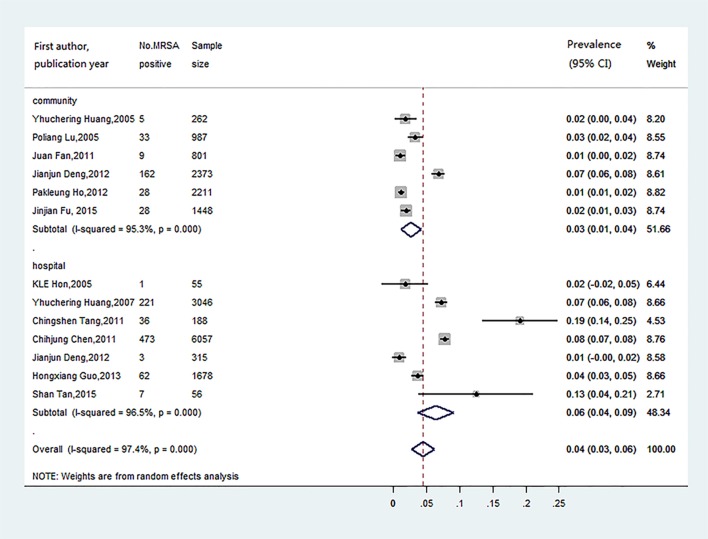
Forest plot for MRSA prevalence and 95% CI for all selected studies.(A) Pooled prevalence estimate of MRSA using random effect. (B) ES: effect size. (C) CI: confidence interval.